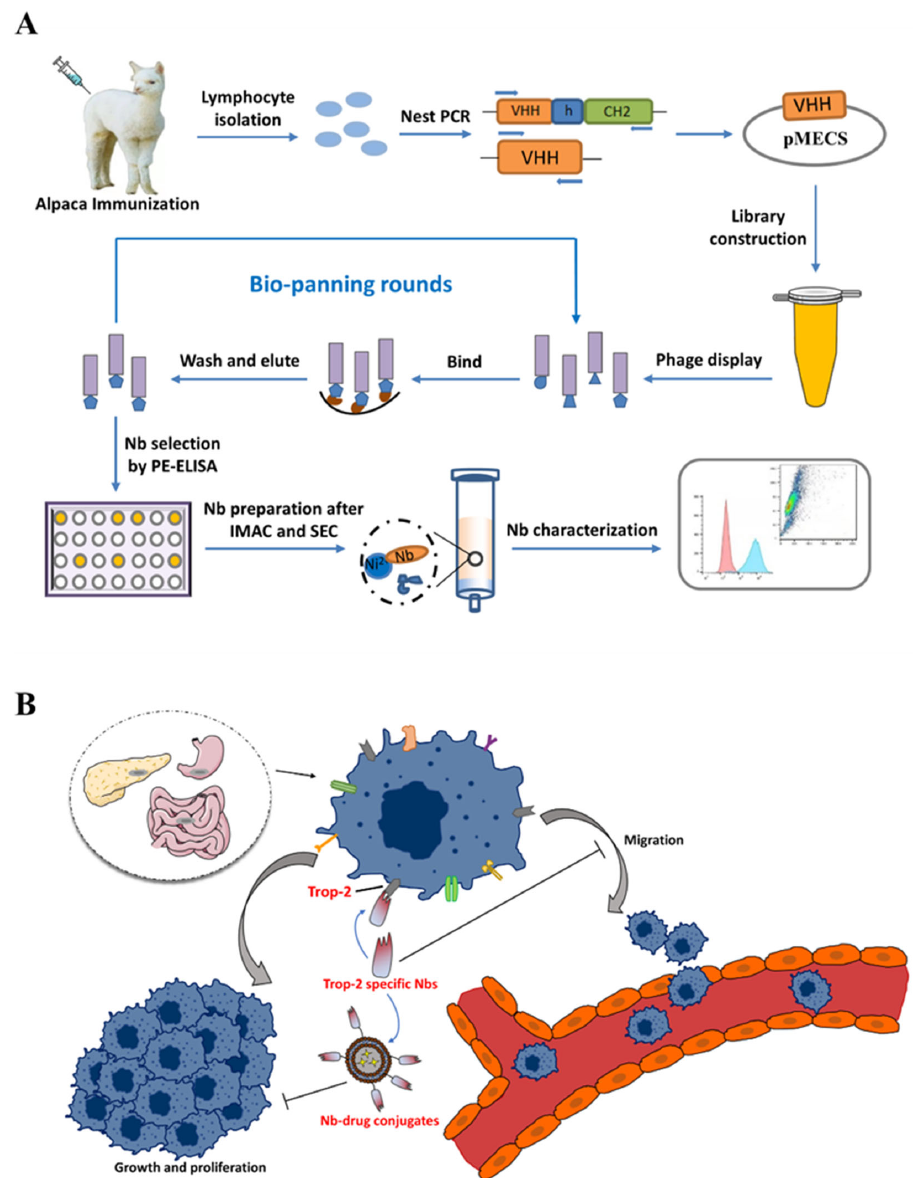
Figure 1. Schematic illustration of Trop ‐ 2 ‐ specific Nb preparation and verification. ( A ) The general strategy for Nb immune library construction and anti ‐ Trop ‐ 2 Nbs selection. ( B ) The general strategy for tumor targeting and inhibition with Trop ‐ 2 specific Nbs.